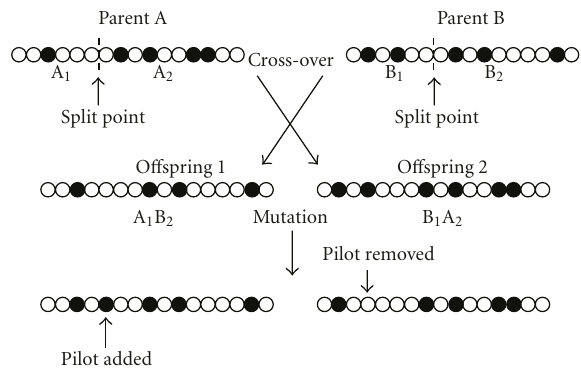
Figure 5: An illustration of cross-over and mutation operations for P = 5. Black circles show pilot